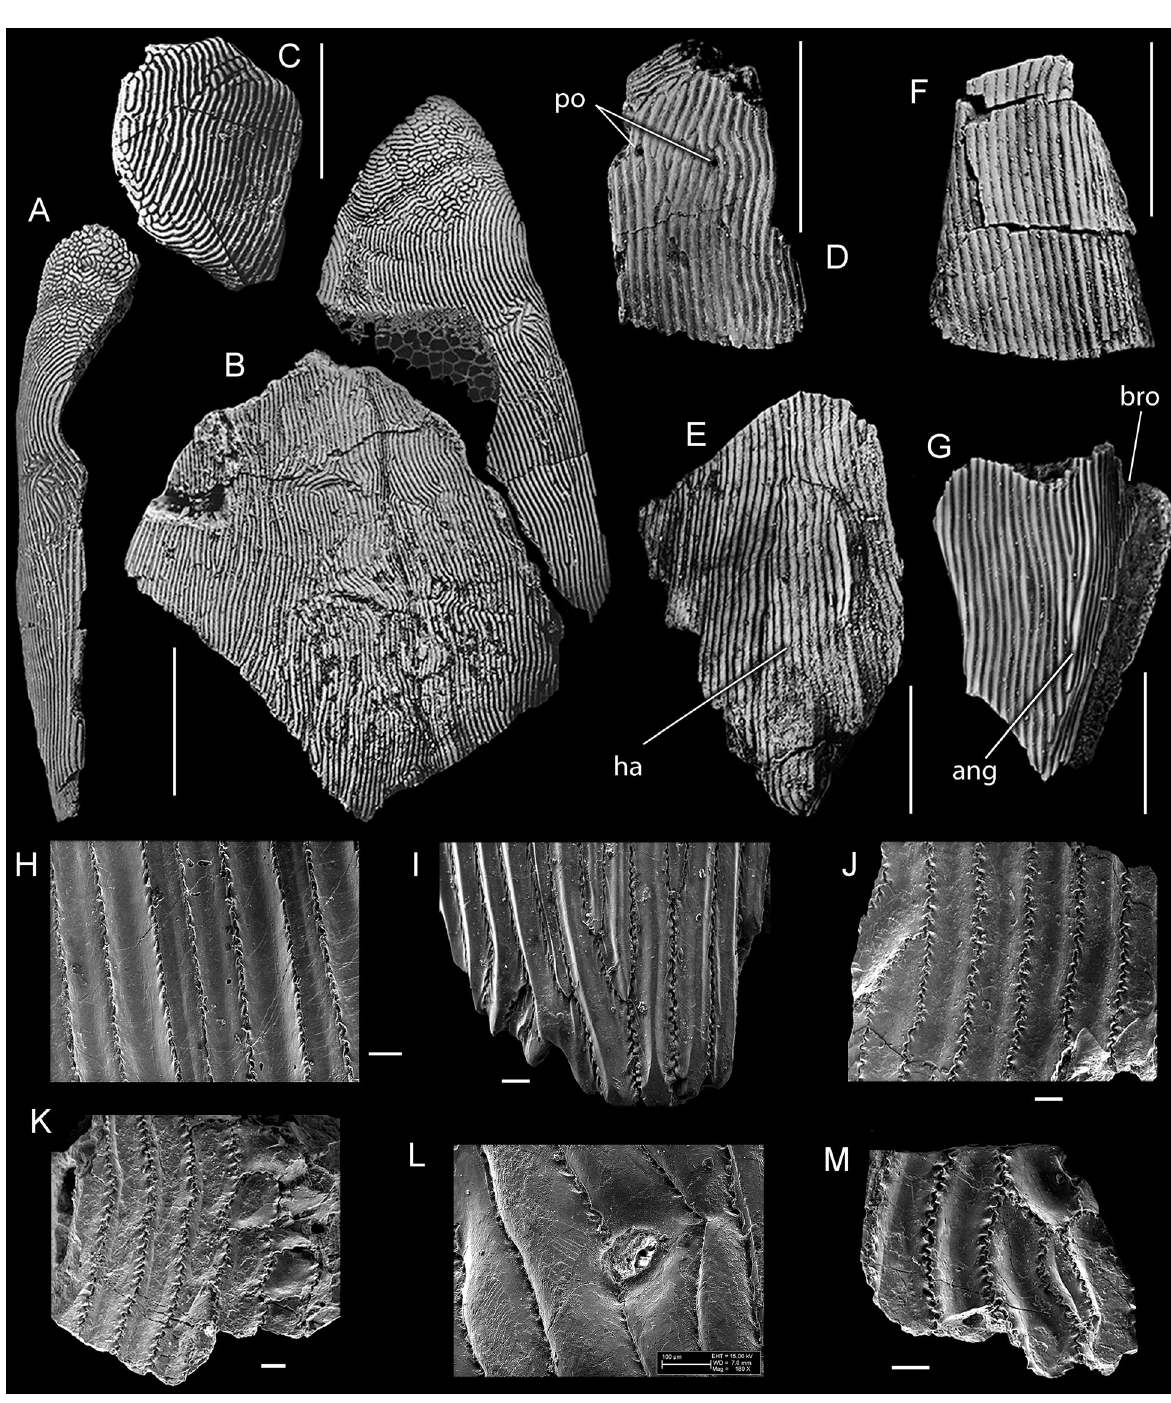
Fig. 3. A–G , Archegonaspis lindstroemi Kiaer from the Central Urals. A, B, broken dorsal shield in right side view (A) and in dorsal view (B), GIT 408-1; C, possibly a lateral plate, GIT 408-11; D, anterior part of a scale or platelet; pores of the lateral line canal accentuated with two black dots, GIT 408-9; E, small portion of the postero-median dorsal shield, GIT 408-10; F, possibly part of a branchial plate, GIT 408-12; G, possibly the posterior part of a branchial plate, GIT 408-13; H–M , examples of fine ridgelets at the margins of dentine ridges; H, Archegonaspis integra (Kunth), GIT 408-50; I, Archegonaspis sp., GIT 408-48; J–M, Cyathaspididae gen. et sp. indet. J, GIT 408-52; K, GIT 408-51; L, GIT 408-49; M, GIT 408-53. Scale bars = 5 mm (A, B); 3 mm (C–G); 100 μ m (H–M). Locations : Tabuska (Vishnevaya Gora) section, locality 85-042 for (A–I, L); locality 85-146-5D for (J, K, M); the Central Urals, Tabuska Beds either of the lower P ř idoli (Shujskij 1981; Shurygina et al. 1981) or upper Ludlow level (Modzalevskaya & Märss 1991). Abbreviations : ang, sharp angulation along the branchial plate; bro, branchial opening; ha, healed area; po, pores of lateral line